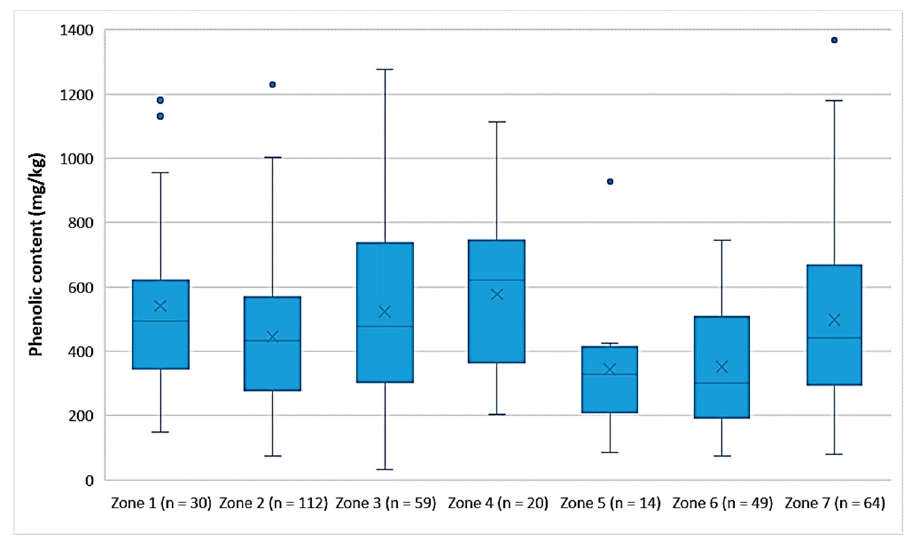
Figure 3. Comparison of the phenolic content (mg/kg) of EVOOs between the zones (Zones 1–7) of the island of Lesvos. Table 6. Statistical parameters for the phenolic content of EVOOs for the seven zones of Lesvos.